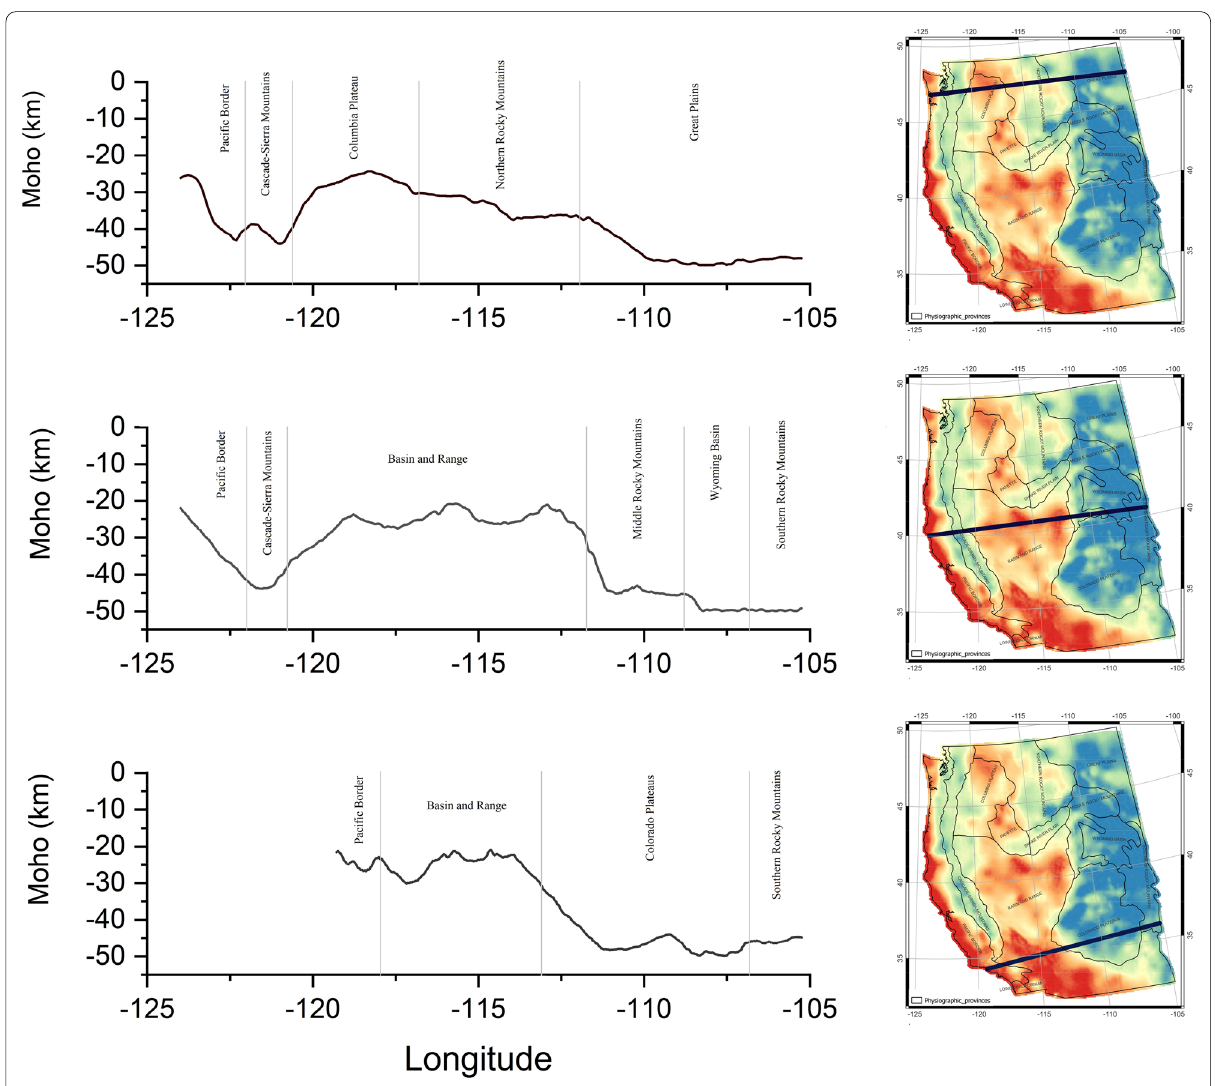
Fig. 8 Extracted east–west profiles in the study